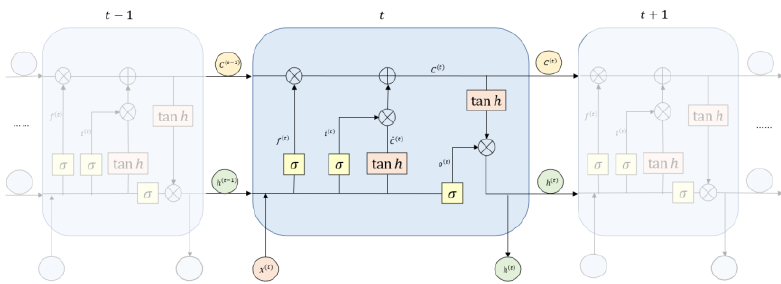
Figure 1. LSTM structure.